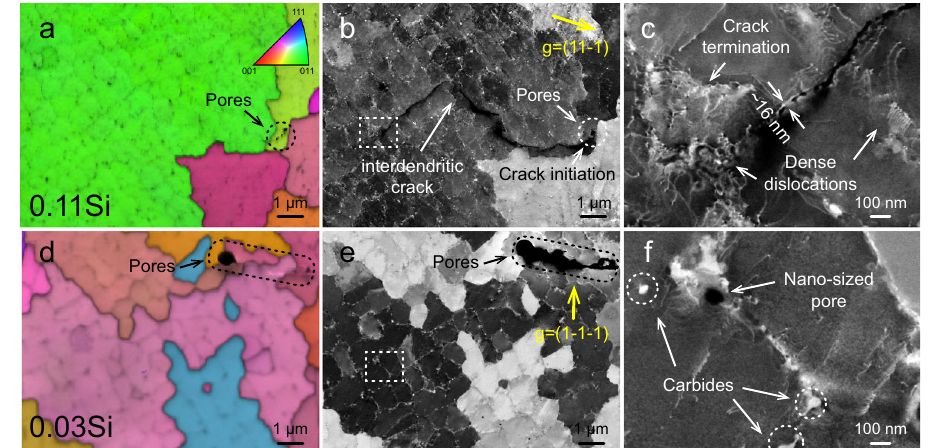
Fig. 3 | Controlled electron channeling contrast imaging (cECCI) images of the 0.11Si and 0.03Si samples containing gas pores. a , d Inverse pole fi gure (IPF) maps of the 0.11Si and 0.03Si samples in the out-of-plane direction perpendicular to the build direction. b , e Corresponding cECCI images of the IPF images with a g